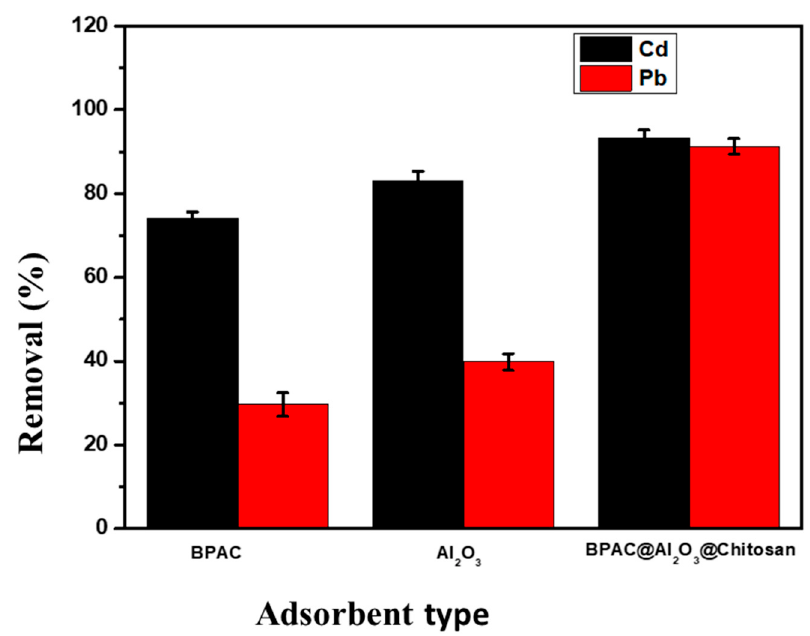
Figure 5. Adsorption of Cd 2+ and Pb 2+ on BPAC, Al 2 O 3 , and BPAC@Al 2 O 3 @chitosan composite ma-